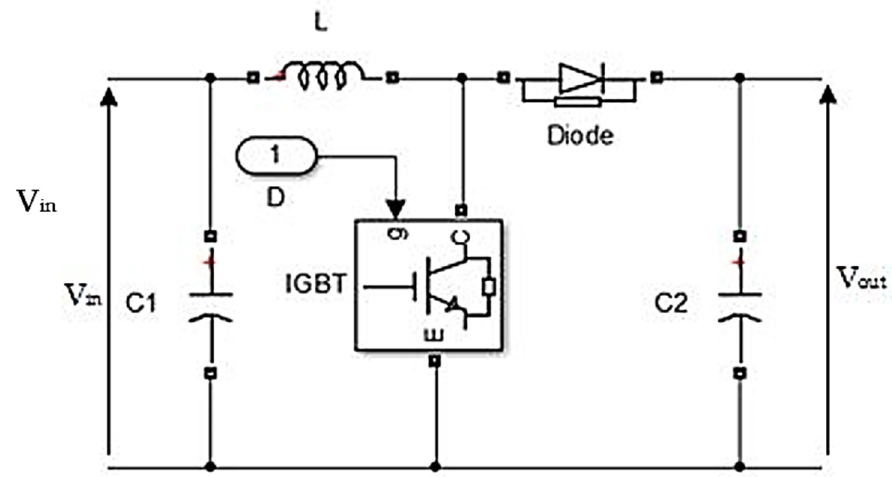
Figure 4. Electrical circuit of boost converter.